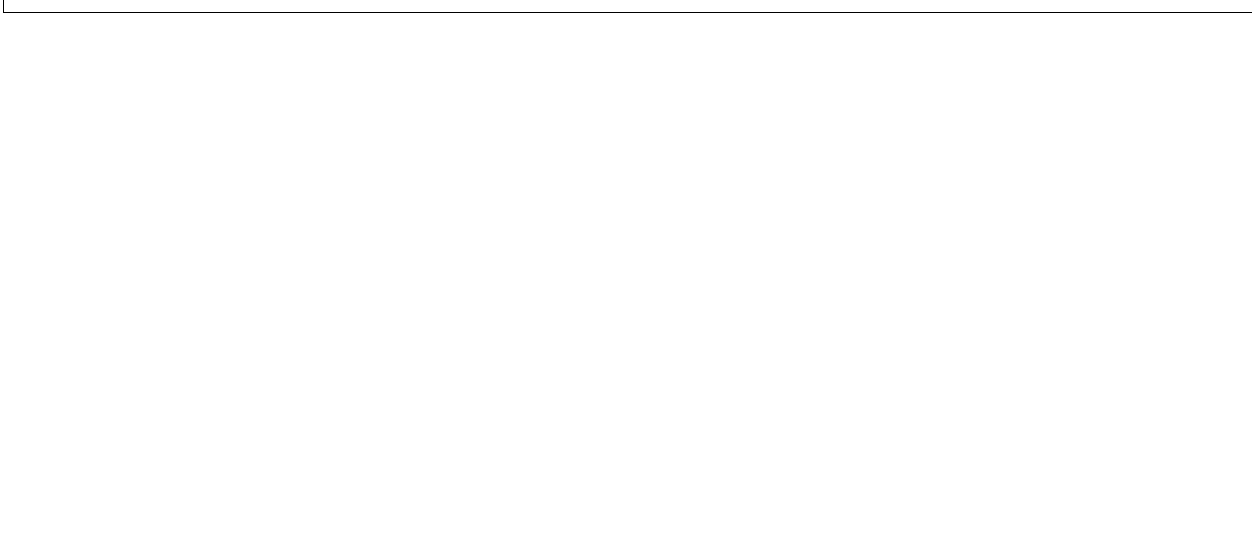
FIGUREA6 | LBA model fit for Participant